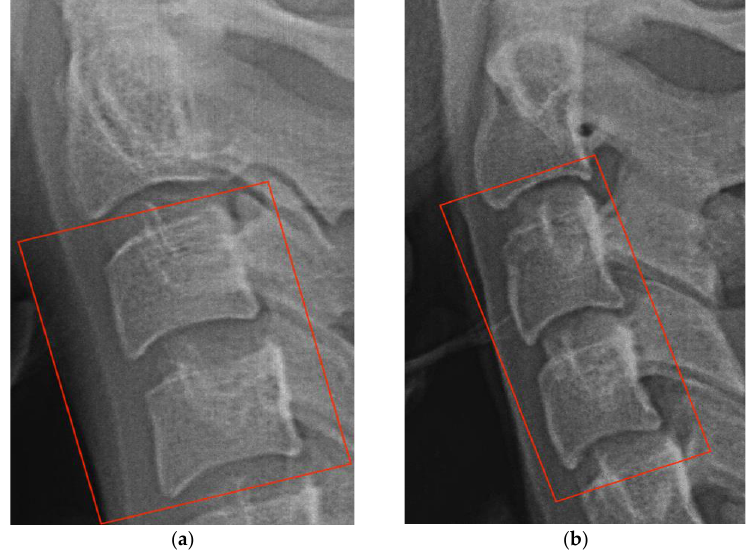
Figure 3. ( a ) The fifth stage. The bodies of the third and fourth cervical vertebrae are square in shape; ( b ) the sixth stage. The bodies of the third and fourth cervical vertebrae are rectangular in form.